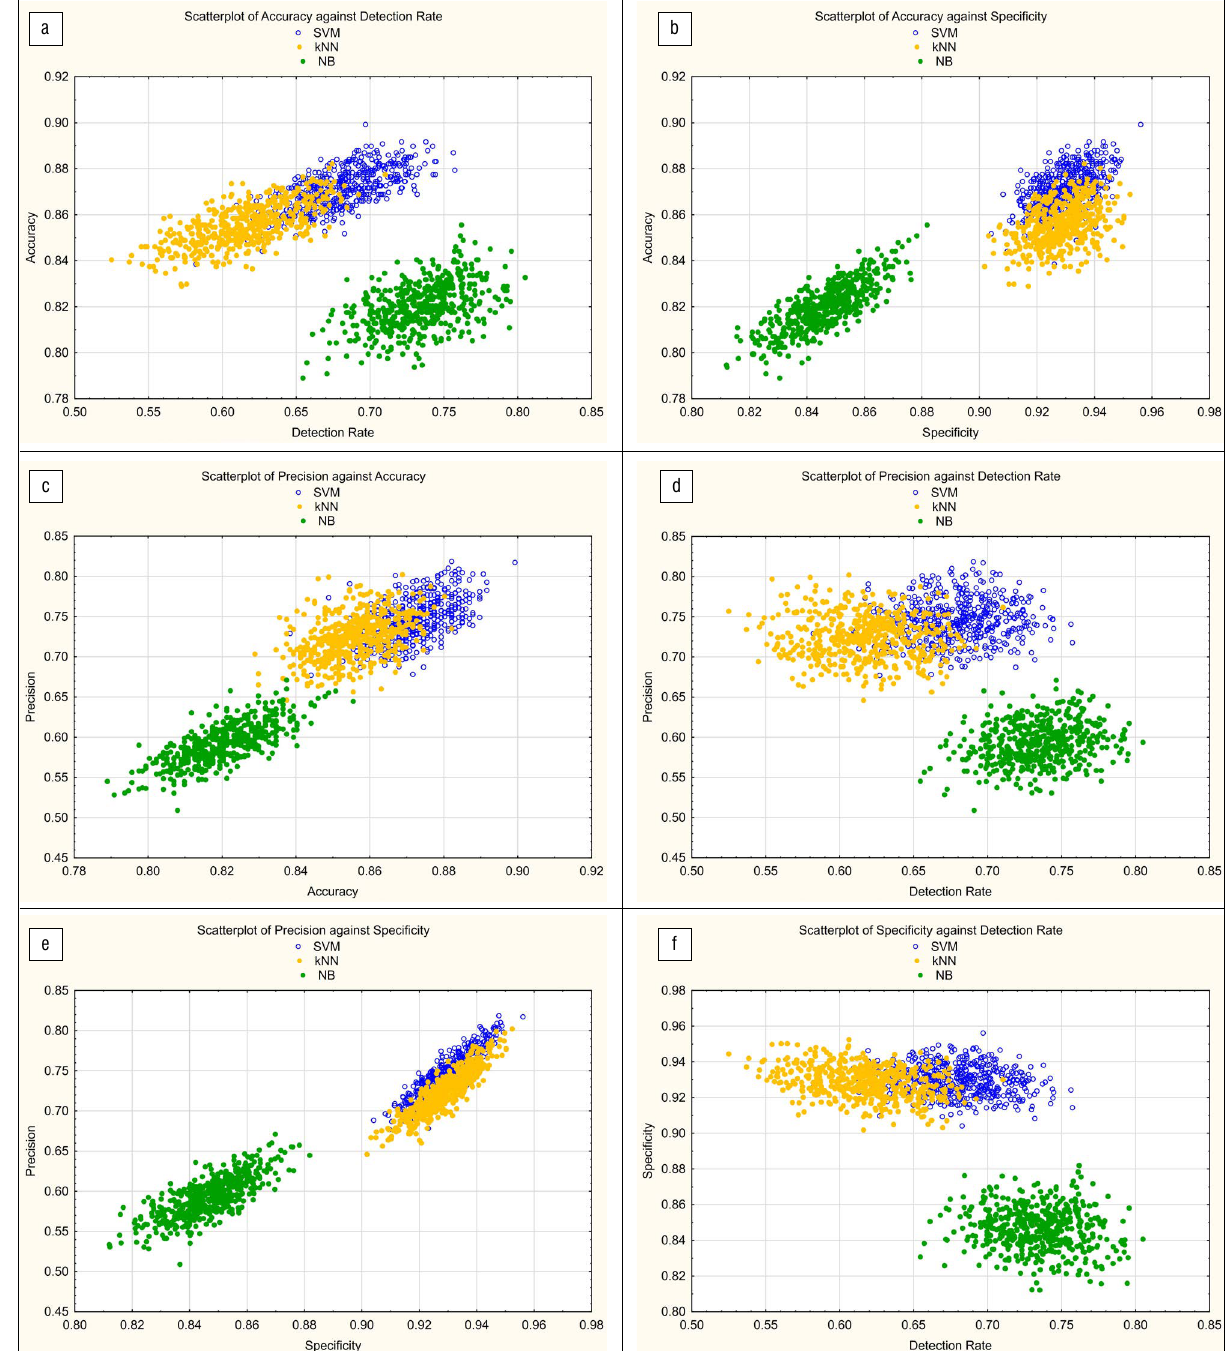
Figure 2: Scatter plots of classifier comparisons in terms of performance